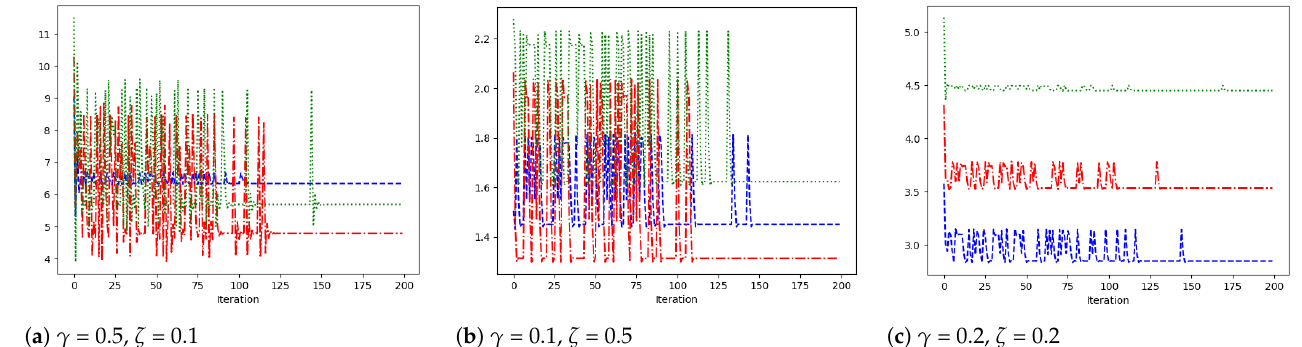
Figure 10. Convergence behaviour of average queue function for multiple user populations (small (blue), medium (red), large